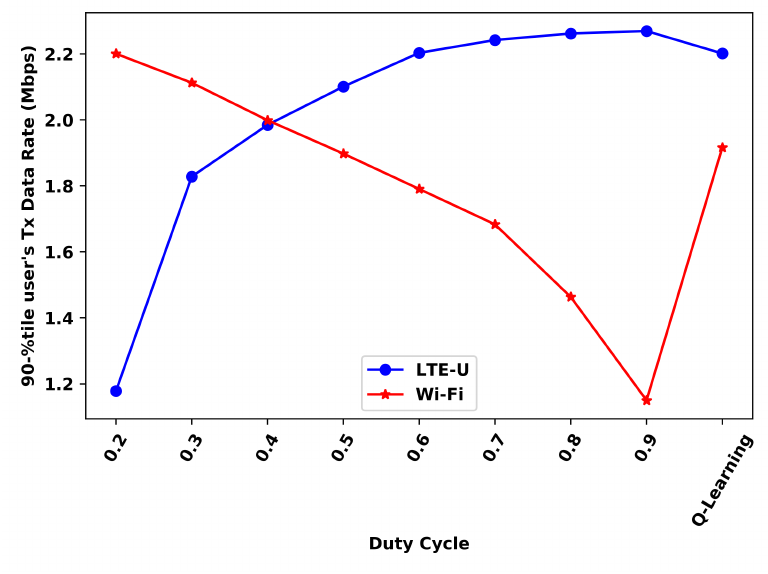
Figure 12. 90th-percentile user’s transmitted data